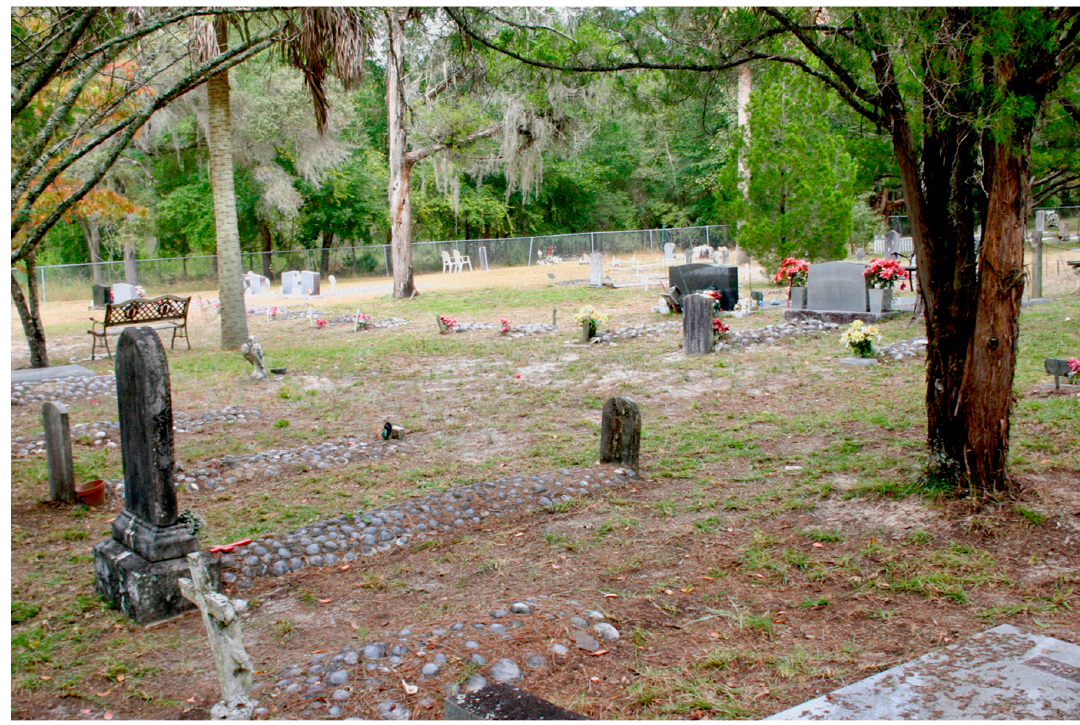
Figure 4. Graves at the cemetery, many covered with shells. Photograph courtesy of the author.